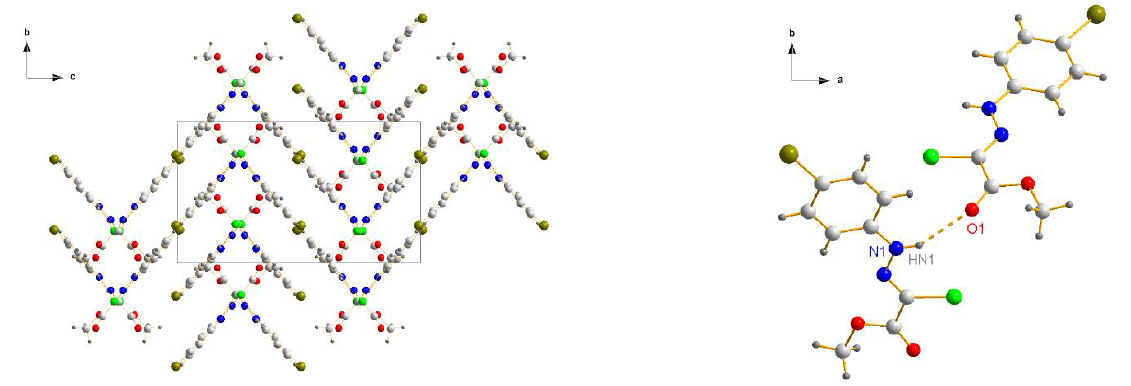
Figure 5. Partial crystal packing views down the a (left) and c (right) axis for compound 3.